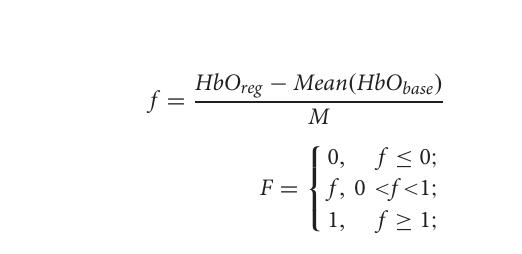
FIGURE 2 | Experimental design overview. (A) Experimental procedure. Both experimental group (Exp) and control group (Ctr) received 8 neurofeedback (NFB) sessions. Before and after training, all participants completed the behavioral assessments. (B) Timeline of one neurofeedback session. (C) Neurofeedback visual interface. Two sample images of the interface depict the fixation (upper) and regulation (lower)